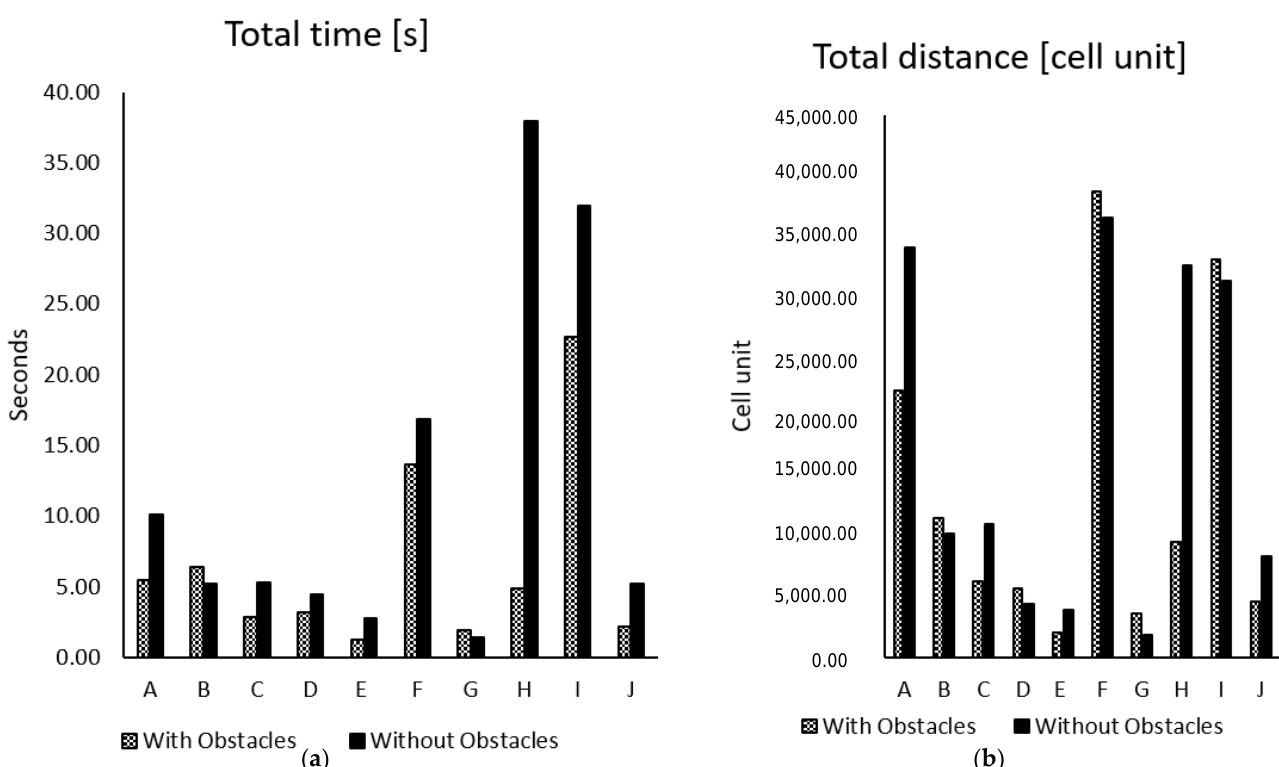
Figure 10. Total search comparison for static obstacle avoidance: ( a ) time, ( b ) distance.